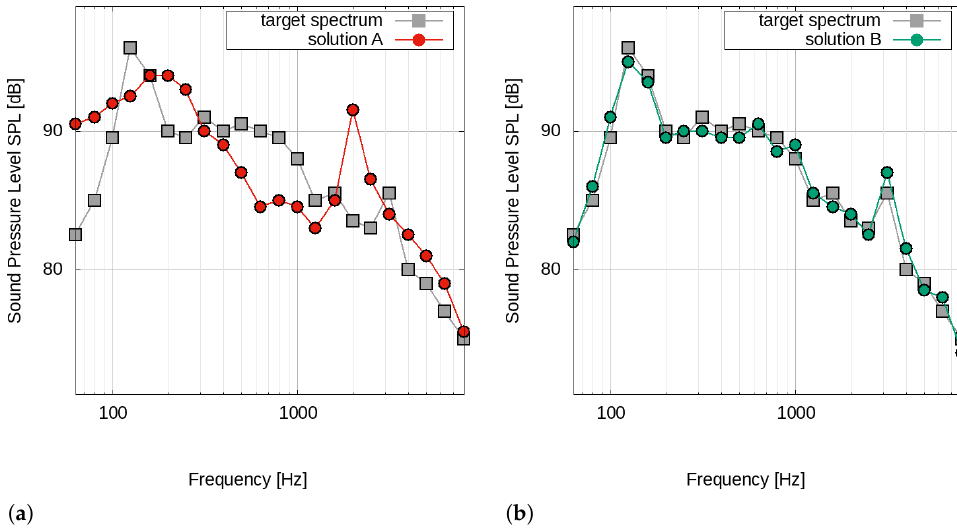
Figure 16. Example of spectral matching. ( a ) solution A: poor matching. ( b ) solution B: good